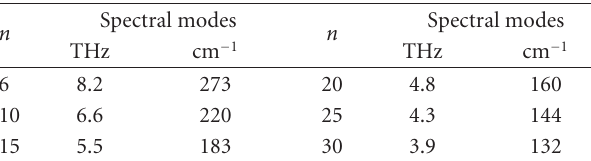
Table 1: The spectral absorption modes of the coherent proton vi- brations as a function of the water-molecules number in the helix, n